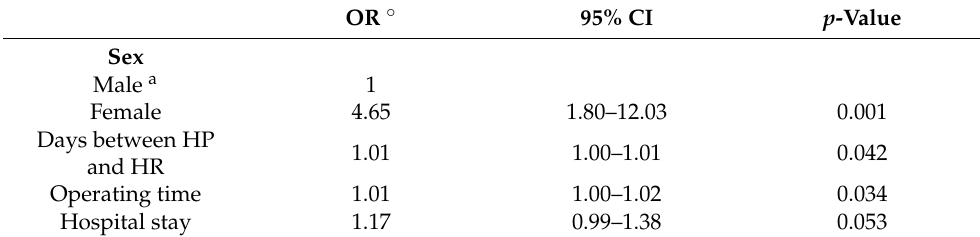
Table 4. Multivariate logistic regression of the factors associated with a higher CCI.